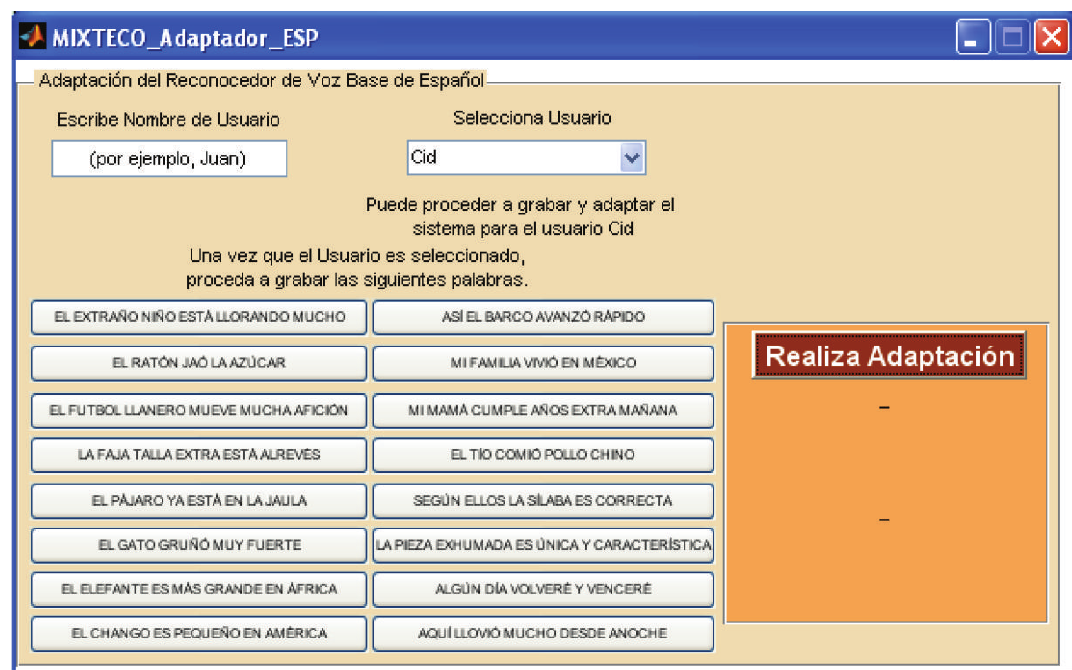
Figure 15: Speaker adaptation module for the baseline Spanish ASR